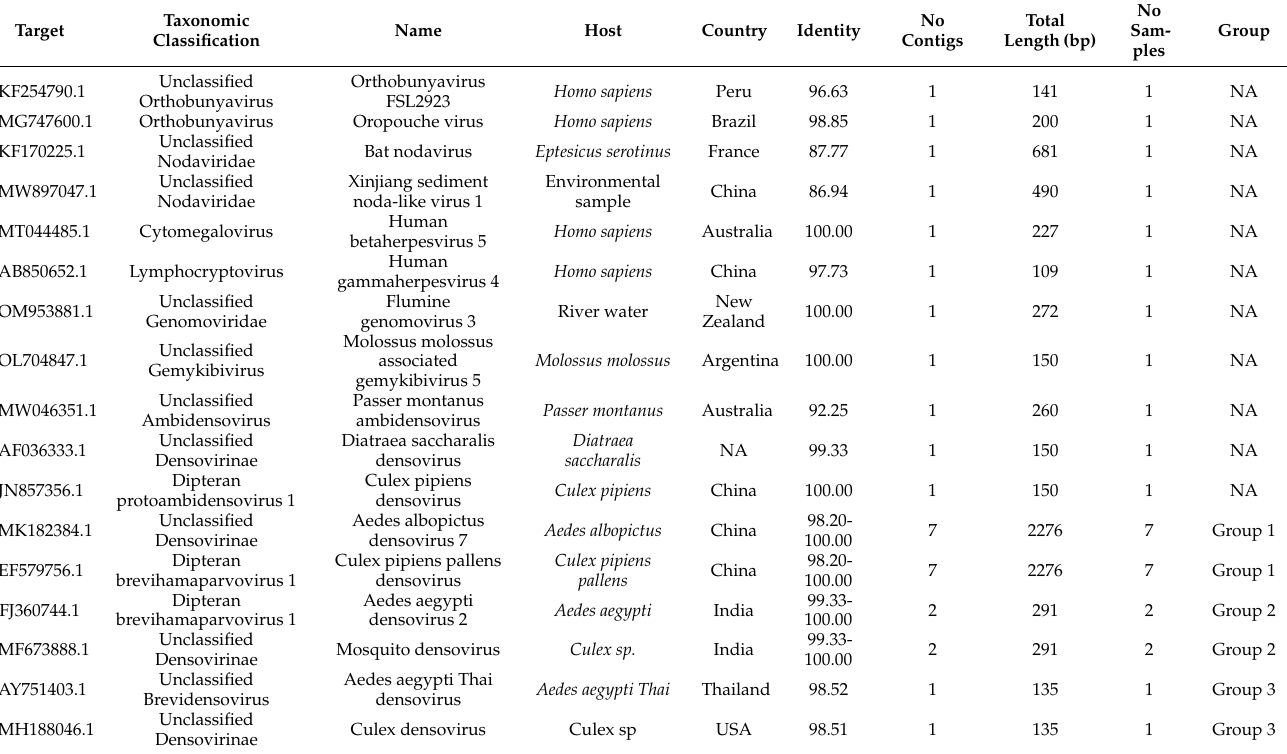
Table 1. Viral sequences with low representation. This table presents the taxonomic classification of viral sequences with vertebrate and/or invertebrate hosts that were represented by a few contigs. The last column indicate the groups that were used to classify the densoviruses. NA: not applicable or not